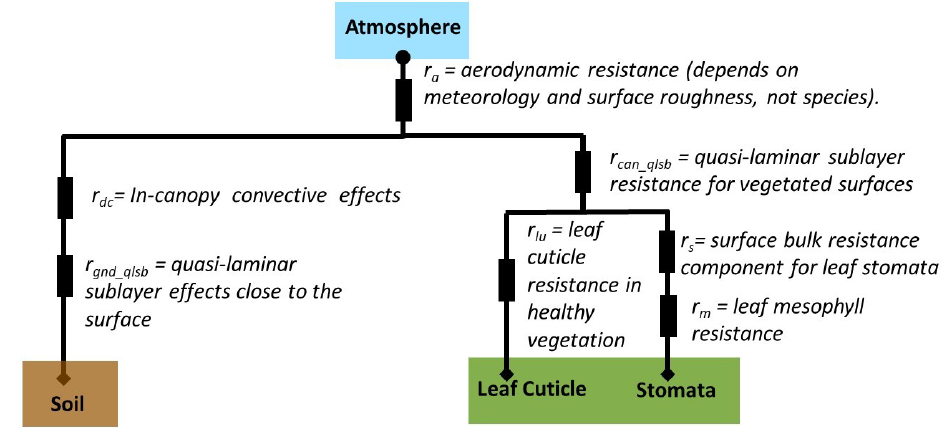
Figure 5. Nemitz bidirectional flux model for NH 3 . Table 7. Variables for bidirectional fluxes of